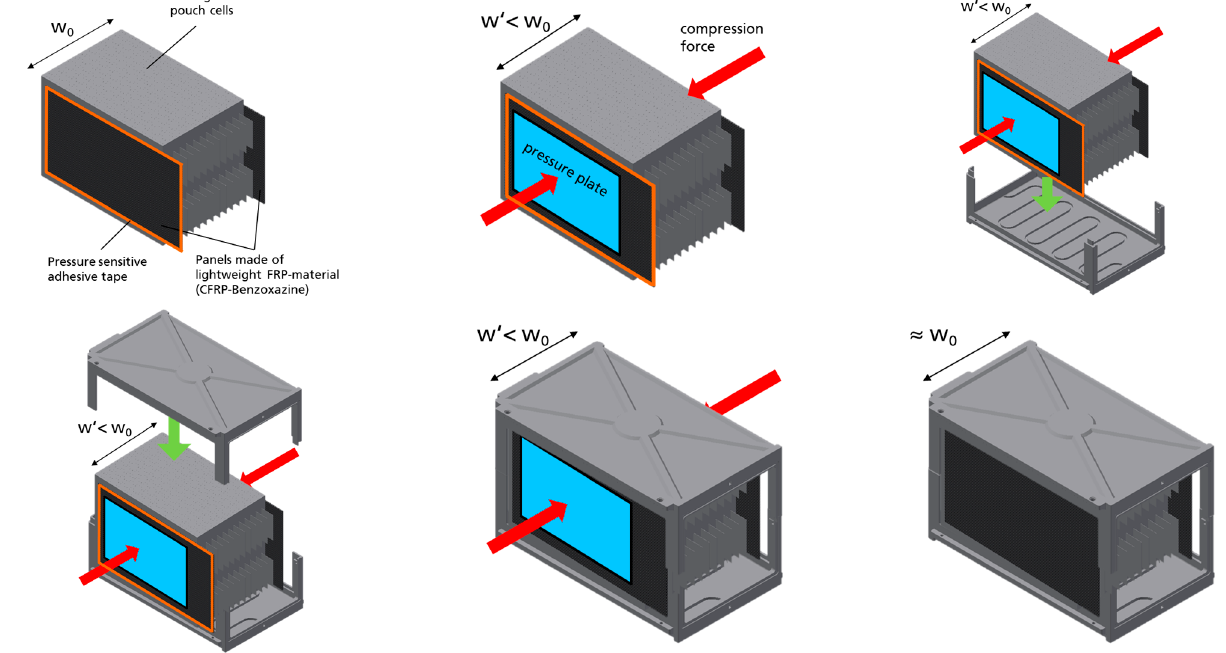
Figure 6. Concept for joining the battery module housing parts.